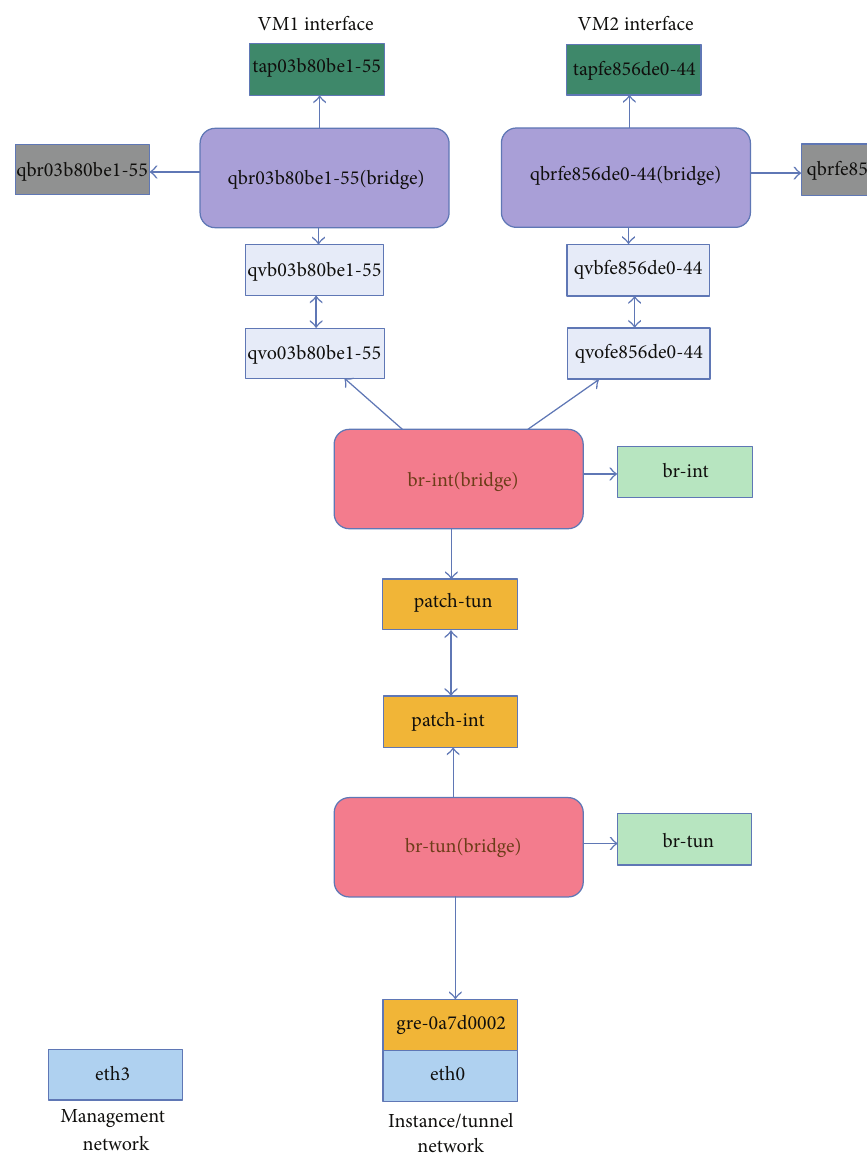
Figure 3: Network elements in an OpenStack compute node running two VMs. Two Linux Bridges (blue boxes) are attached to the VM tap interfaces (green boxes) and connected by virtual Ethernet pairs (light-blue boxes) to br-int